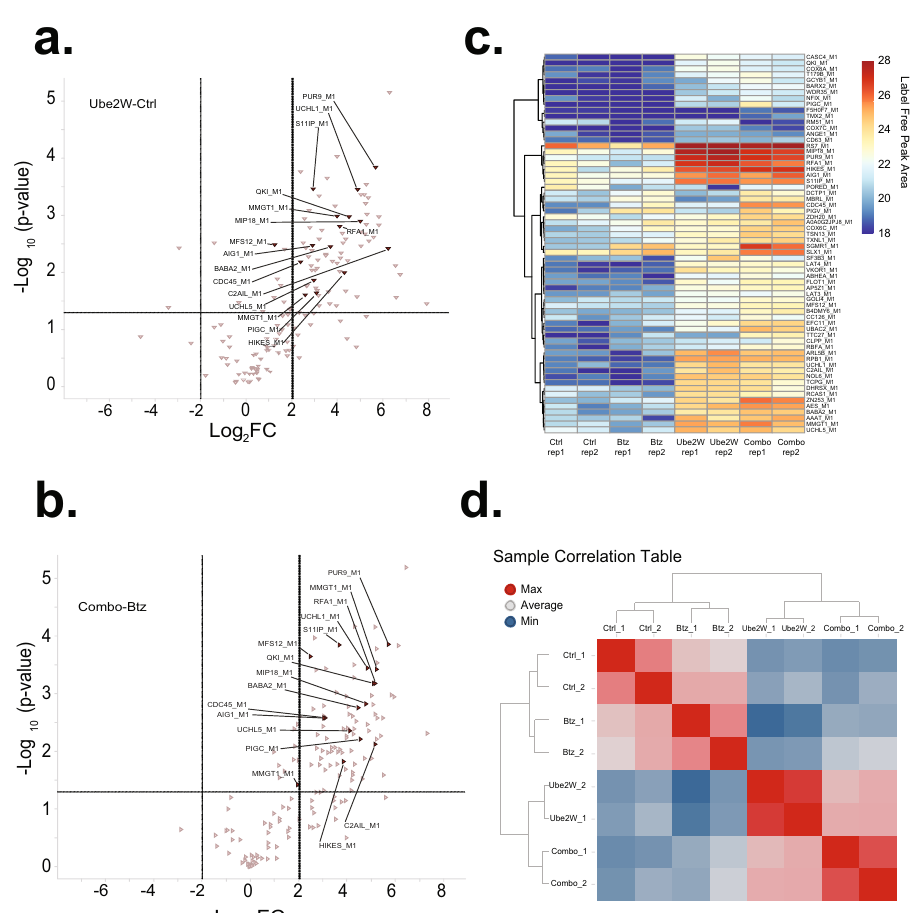
Fig. 9 N-terminal ubiquitination is unaltered by proteasome inhibition. a , b Volcano plot showing differential N-terminal protein ubiquitination data for UBE2Woe versus Control ( a ) and Combo versus bortezomib (Btz)-treated ( b ) conditions in label-free GGX-MS experiment. Each data point represents one protein with a representative set of human UniProt proteins shown. c Sample correlation table showing Ctrl, Btz-treated, UBE2W overexpressing ( + Dox) and Combo ( UBE2W overexpressing + Btz-treated) samples with high correlations shown in red and poorly correlated samples shown in blue. d Clustered heatmap of N-terminally modi fi ed GGX peptides from selected proteins. Log 2 -transformed label-free peak areas (AUC) are shown on a color scale ranging from blue to red. Values below 18 were deemed to be indistinguishable from the noise and censored.